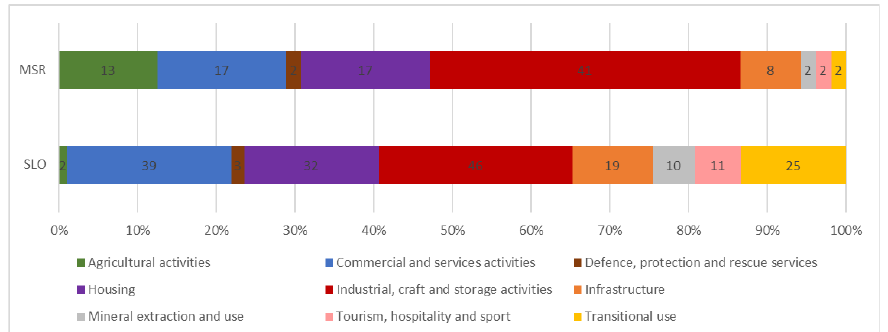
Figure 5. Regenerated brownfields by the type (2017 – 2022). Based on [24 – 27]. Prepared by the au- thors.